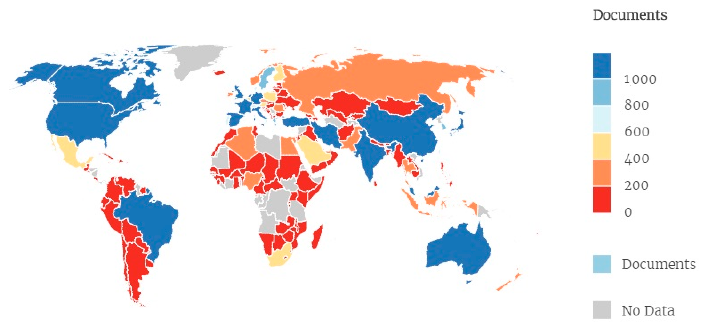
Figure 4. Distribution of renewable energy in urban areas publications according to country.